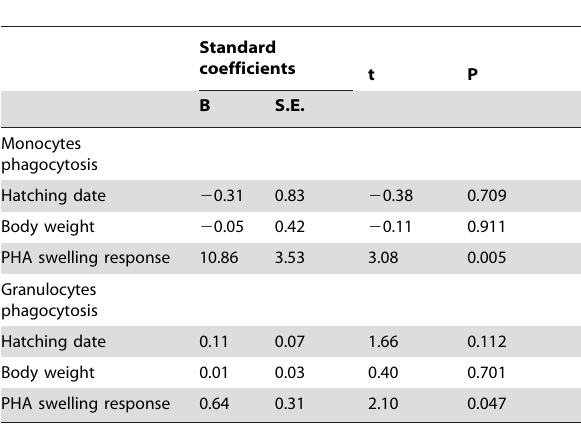
Table 3. General Linear Models relating hatching date, body weight and PHA swelling response to monocytes and granulocytes